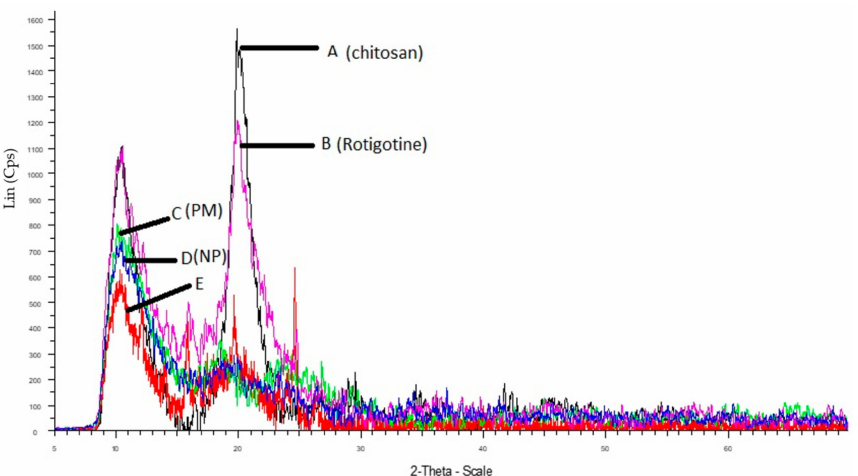
Figure 9. X-ray diffraction of ( A ) chitosan, ( B ) rotigotine, ( C ) physical mixture (drug + polymer), ( D ) drug loaded NPs, and ( E ) placebo NPs.